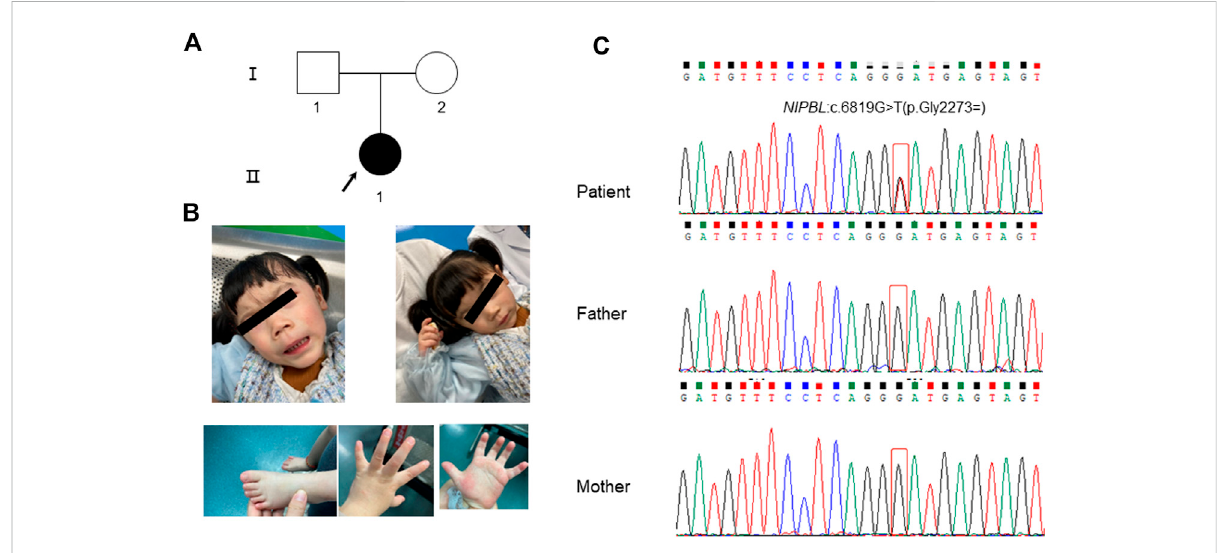
FIGURE 1 Clinical featuresofthepatient andSangersequencingresultsofherfamilymembers. (A) Pedigreeofthefamily.Thearrowindicatesthepatient. (B) The patient presented with typical facial features of Cornelia de Lange syndrome (CdLS). (C) The results of Sanger sequencing for the patient and her parents. A heterozygous synonymous variant of NIPBL (NM_133433.4): c.6819G > T (p.Gly2273 = ) was detected in the patient while her parents showed the wild-type variant.